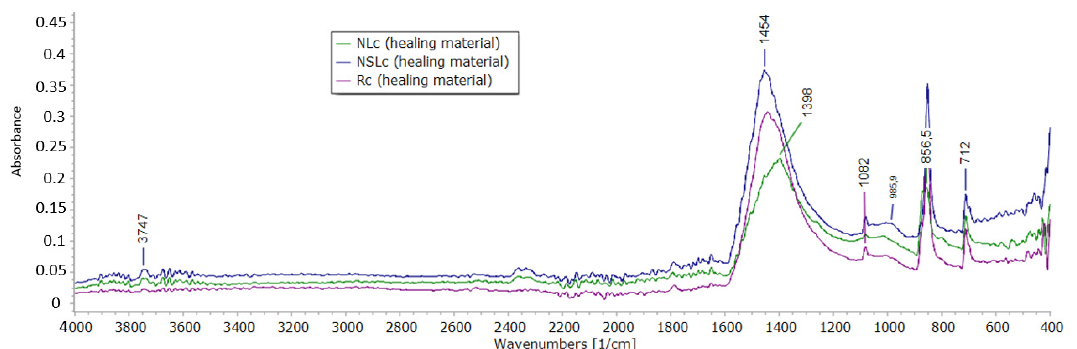
Figure 9. ATR spectra of the healing material obtained from the crack of the samples cured under wetting-drying cycles.